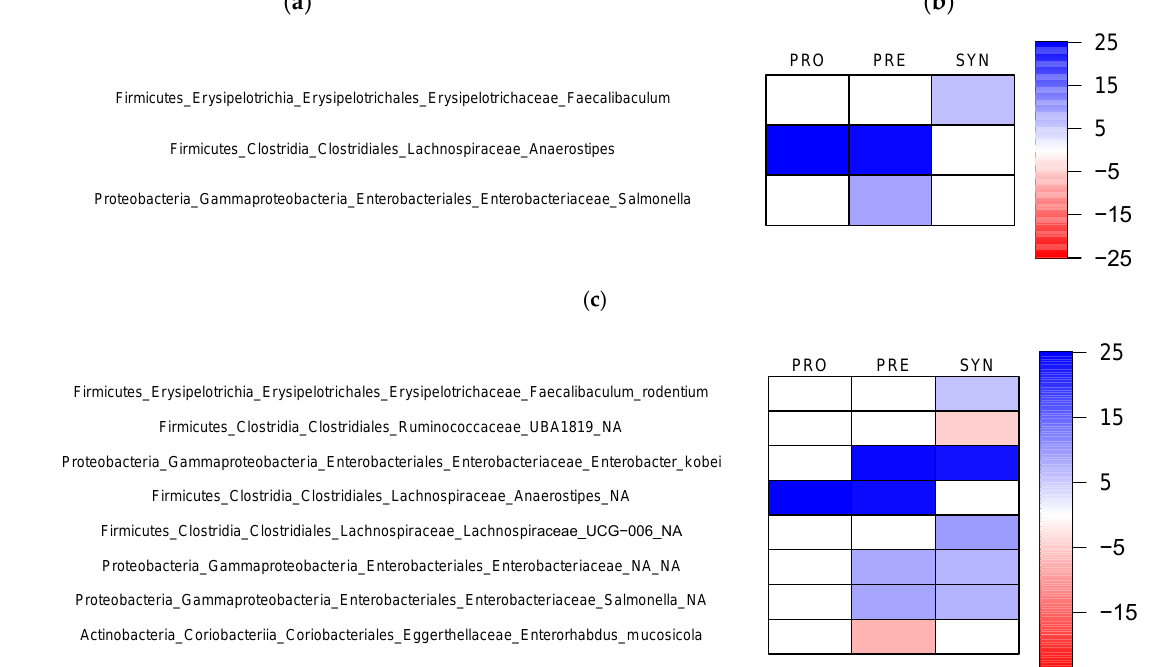
Figure 6. Beta diversity, alpha diversity and gut microbiota composition of BTBR mice at baseline and three weeks post- treatment. ( a ) Beta diversity differences; ( b ) change in alpha diversity. These values are determined by calculating the difference between Shannon diversity at baseline and following the treatment. A negative value represents a decrease in alpha diversity and a positive value represents an increase in diversity. Heatmap highlighting the relative abundances of gut microbiota, at the ( c ) genus and ( d ) species level, of prebiotic-, probiotic- and symbiotic-consuming BTBR mice, which differ significantly from the control group.